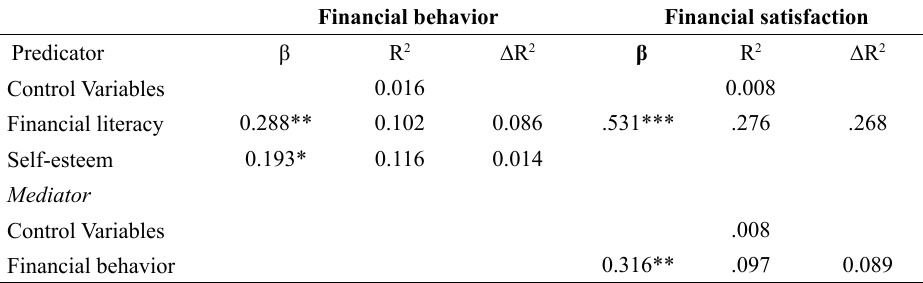
Hierarchical Regression Analysis for